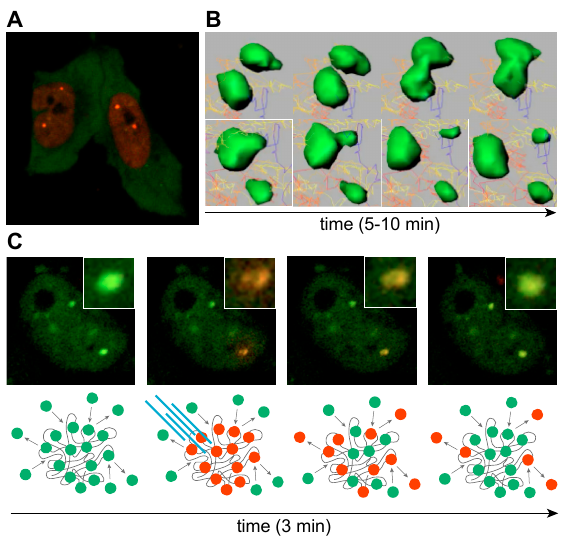
Figure7. MBNLsequestrationonexpandedCUG exp transcripts. ( A